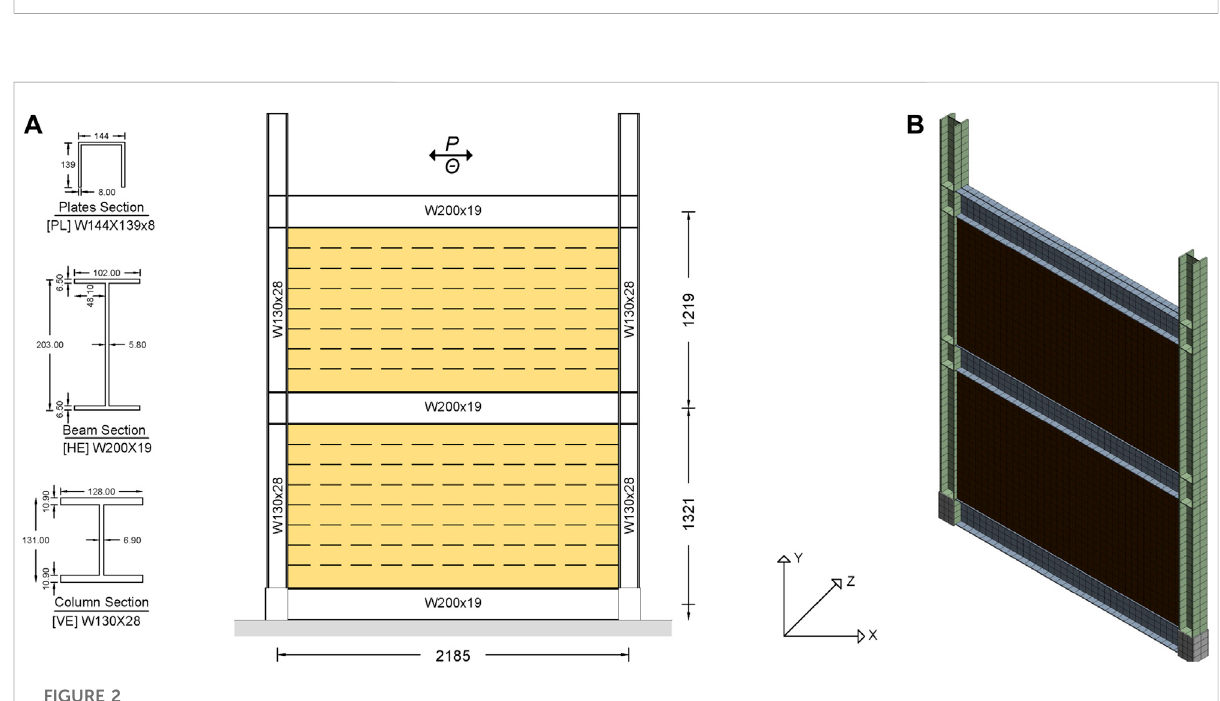
FIGURE 2 STSW Hybrid System (A) Specimen con fi guration, (B) Finite element model.